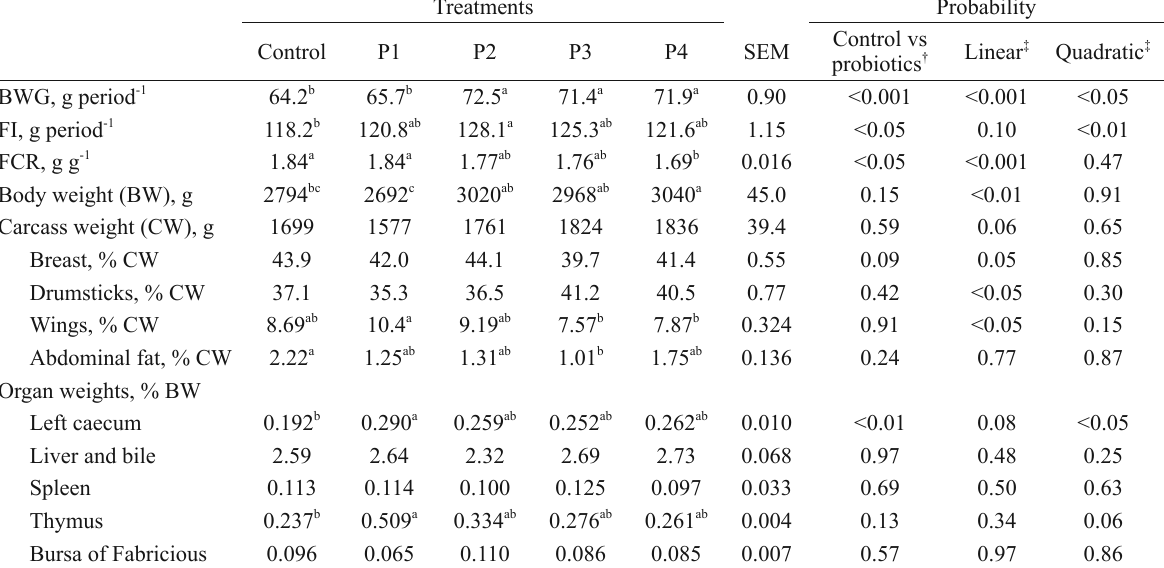
Body weight gain (BWG), feed intake (FI), feed conversion rate (FCR), carcass traits and organ weights of 6-week old broilers fed diets containing either no probiotics (control) or 0.005%, 0.01%, 0.015% and 0.02% of probiotics (P1, P2, P3 and P4, respectively). Carcass and organ measures were obtained from four birds per